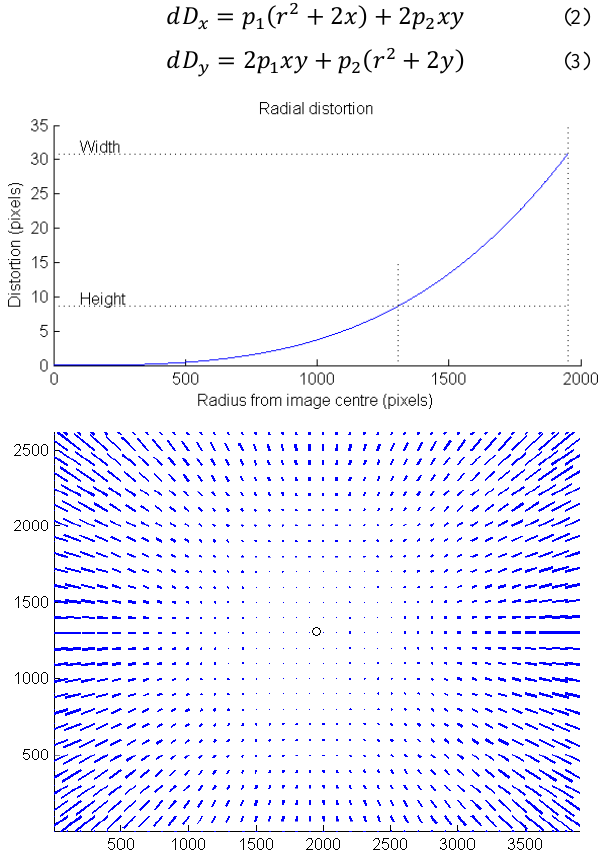
Figure 5. Radial distortion in pixels (top) and distortion vectors of length x5 (bottom) for the Nikkor zoom lens set to 35